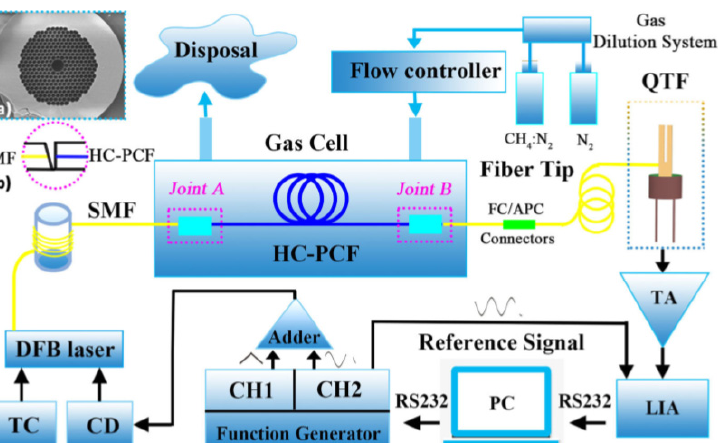
Figure 13. ( a ) A scanning electron microscope (SEM) image of the HC-PCF. ( b ) Experimental setup of the all-fiber LITES sensor system. TC: temperature controller; CD: current driver; DFB laser: distributed feedback diode laser; CH: channel; SMF: single-mode fiber; HC-PCF: hollow-core photonic crystal fiber; QTF: quartz tuning fork; TA: trans-impedance amplifier; LIA: lock-in amplifier. Reprinted/adapted with permission from Ref. [69]. Copyright 2020, copyright The Optical Society.